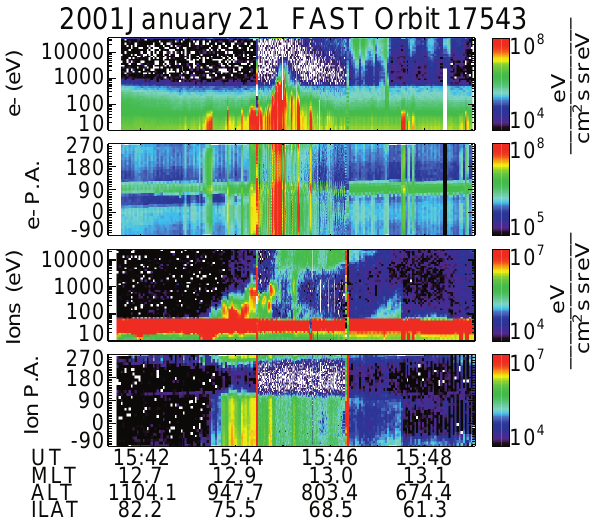
Fig. 8. Spectrograms of particle data from the FAST spacecraft as it passes through the cusp. Top to bottom: electron energy, electron pitch angle, ion energy, and ion pitch